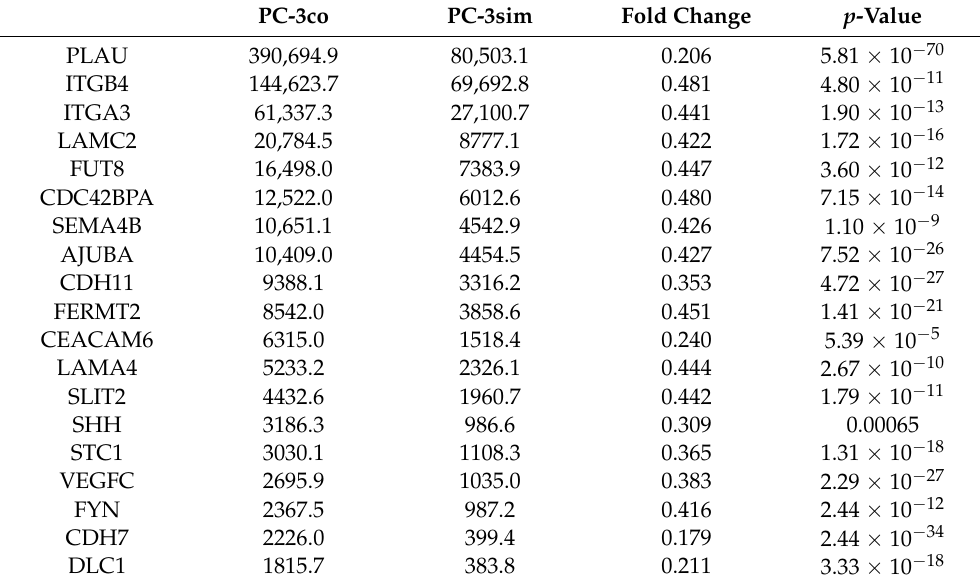
Table 3. List of significantly downregulated genes (fold change < 0.5, n = 3) in PC-3sim compared to PC-3co